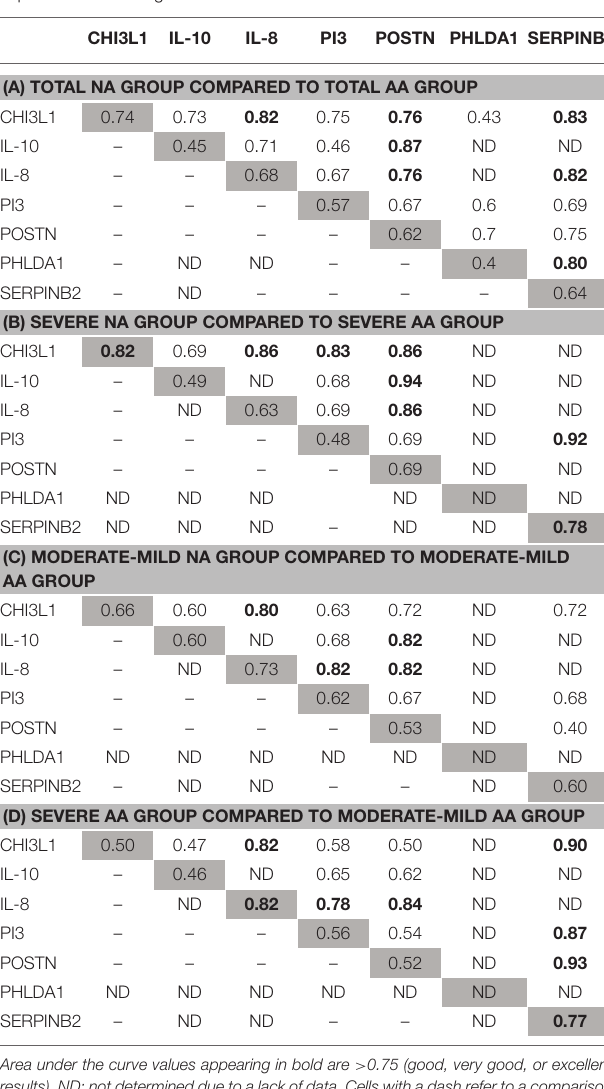
TABLE 4 | Receiver operating characteristic (ROC) curve analysis of the protein expression combining three